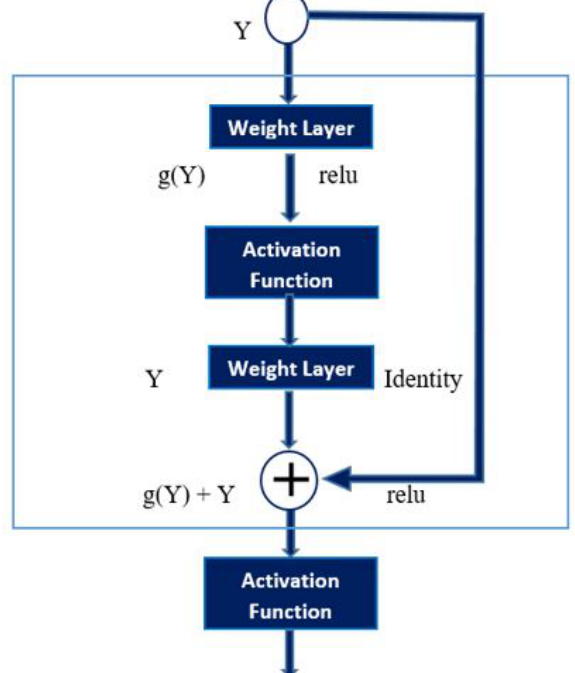
Figure 4. Illustration of residual